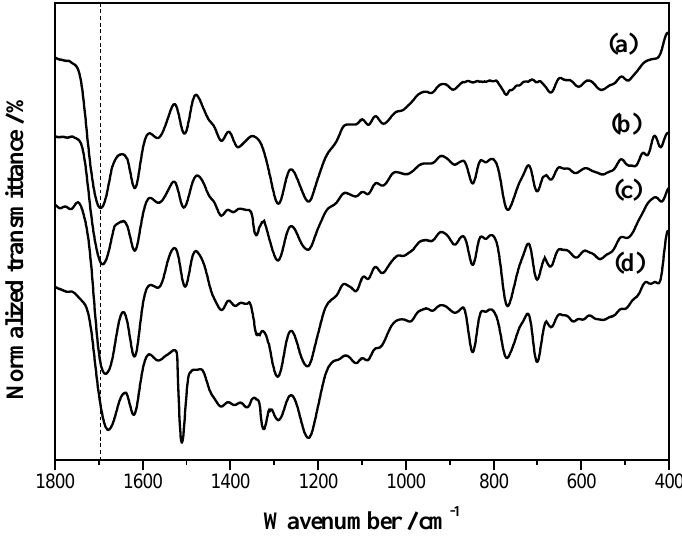
Figure 3. FT-IR spectra of ( a ) PICA; ( b ) P(ICA4- co -EDOT1); ( c ) P(ICA3- co -EDOT2); and ( d ) P(ICA2- co